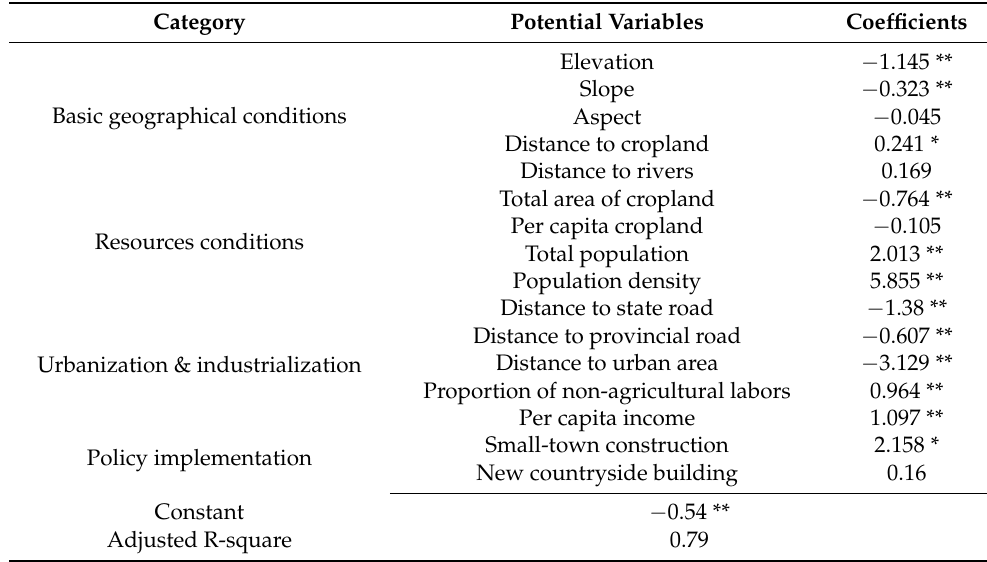
Table 3. Coefficients of driving factors of rural residential land